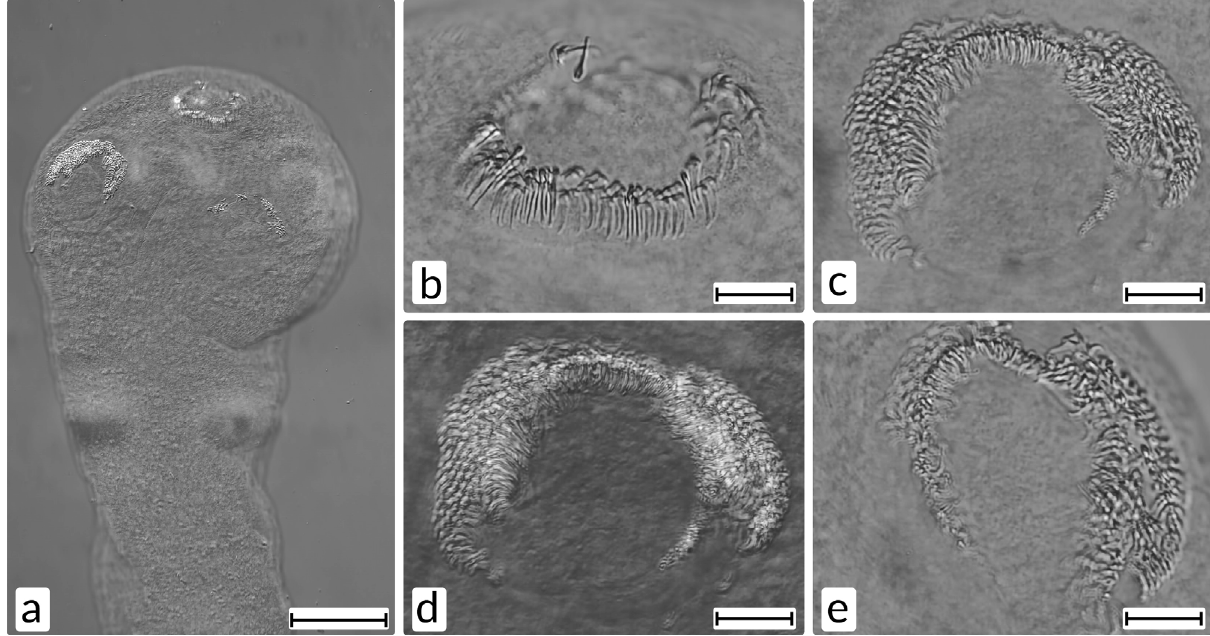
Figure 4. Raillietina friedbergeri ; ( a) , scolex; ( b ), armature of rostellum; ( c – e ), armature of suckers. Scale bar: a, 100 µ m, ( b – e ), 20 µ m. Table 3. Ecological indices characterizing the structure of the component community and infracommunity and the prevalence and intensity of infection of partridges and pheasants, Poland, 2015–2017. The number of birds examined is given in brackets.